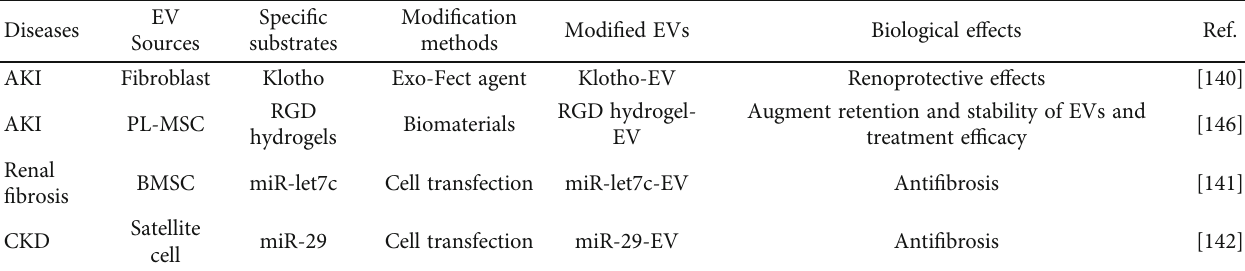
Table 7: Modi fi ed EVs in the therapy of renal